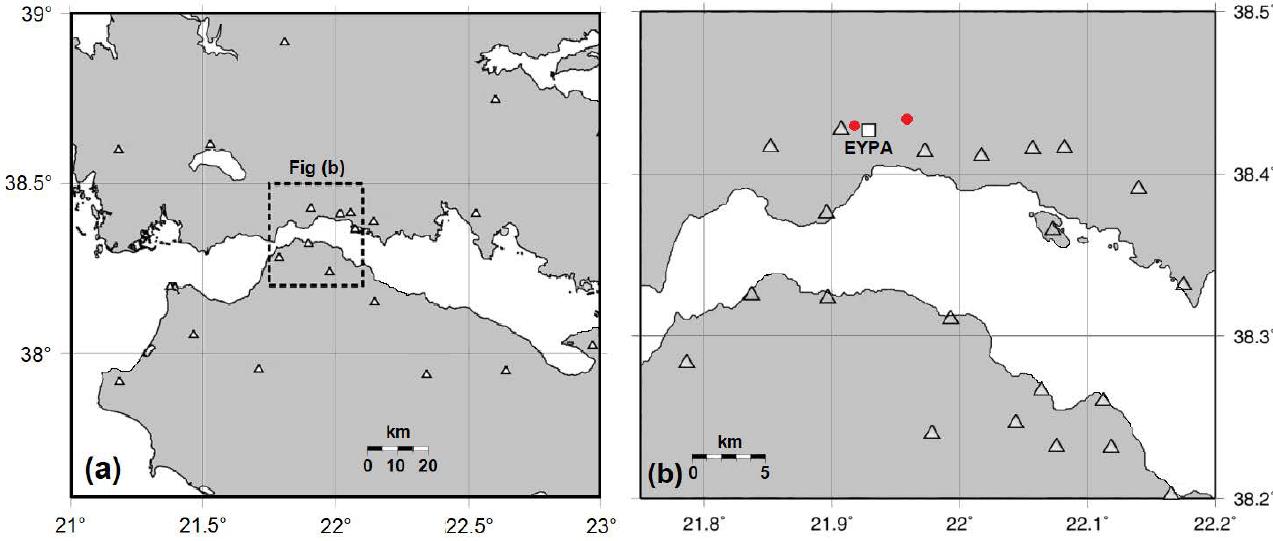
Figure 2. Geographical distribution of the seismic permanent observing stations (triangles). The permanent GNSS station EYPA is shown as square. The red circles are the epicentres of Efpalio earthquakes (from